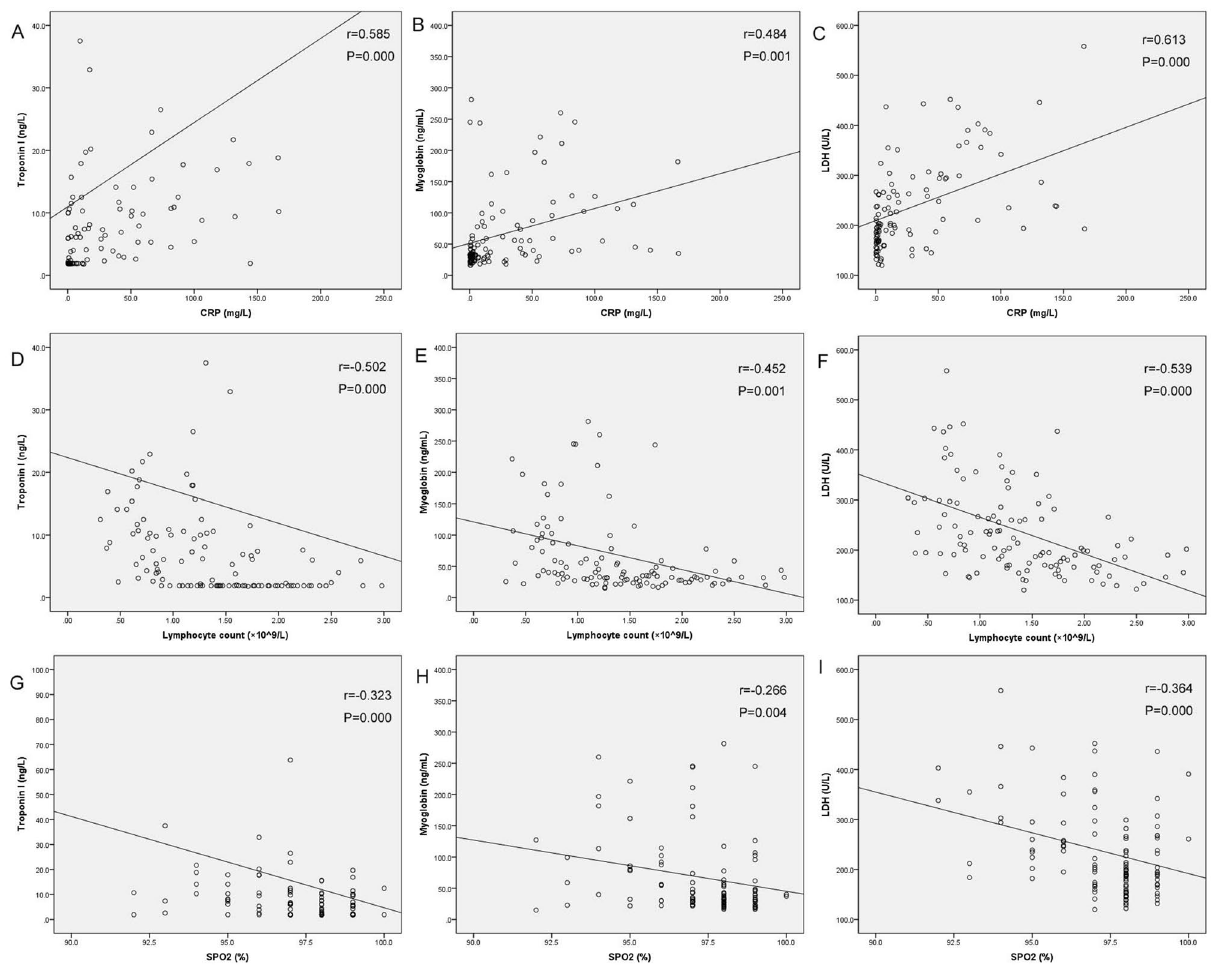
Figure 1. Scatter plots of cardiac biomarkers and SPO 2 , lymphocyte count, and CRP. The levels of cardiac biomarkers were significantly correlated with those of SPO 2 , lymphocyte count, and CRP. SPO 2 , pulse oximeter O 2 saturation; CRP, C-reactive protein; hs-cTnI, high sensitivity troponin I; BNP, B-type natriuretic peptide; CKMB, creatine kinase-myocardial band; LDH, lactic